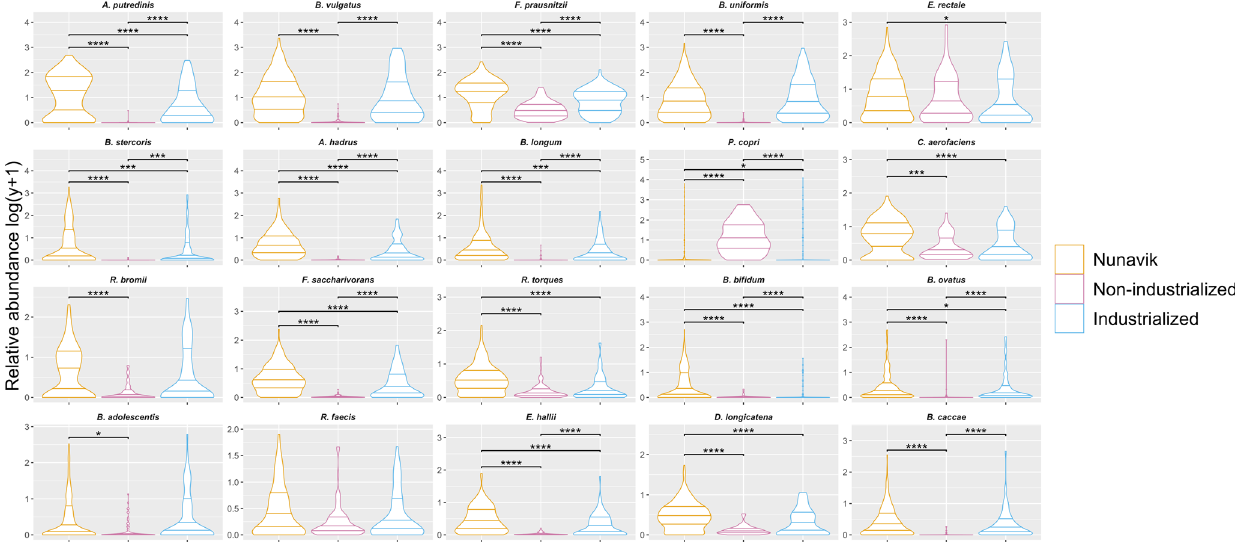
Fig. 4 Top 20 most abundant species in the gut microbiome compared to individuals from non-industrial and industrial societies. Violin Plots represent the relative abundance (%) of the top 20 species in the gut microbiome of Nunavik youth in comparison to non-industrialized and industrialized reference populations, from most abundant to less abundant. (Wilcoxon-Mann-Whitney; * p -value ≤ 0.05, ** p -value ≤ 0.01, *** p -value ≤ 0.001, **** p -value ≤ 0.0001).